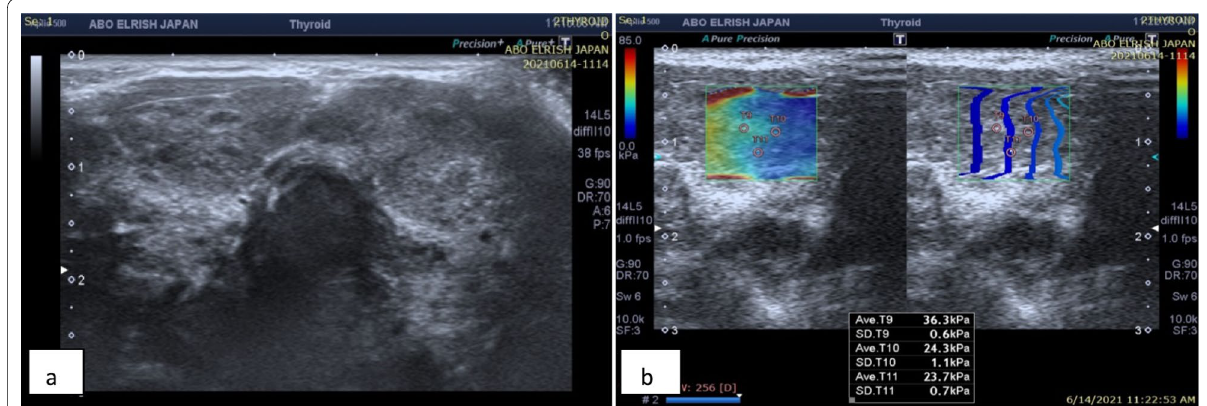
Fig. 5 a Gray scale findings in an 8-year-old female with positive anti-thyroglobulin and anti-microsomal antibodies, showing inhomogeneous increased echogenicity with hyperechoic septations of both thyroid lobes. b SWE showing three measurements of elasticity (36.3, 24.3 and 23.47 kPa) of right thyroid lobe in longitudinal